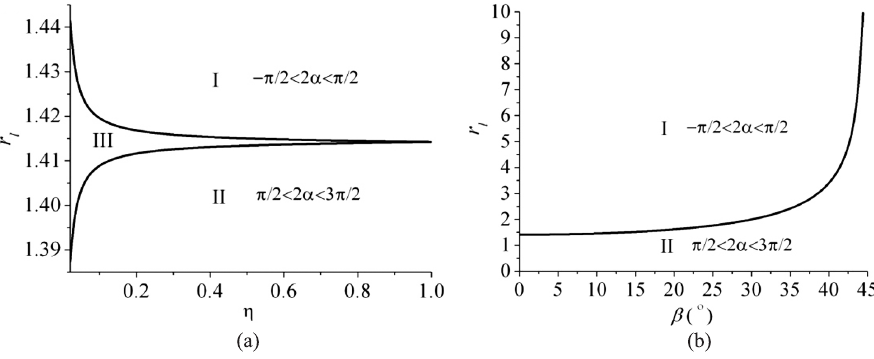
Fig. 3. Regions of frequency capture for the two identical motors: (a) β = 0 ; (b) β ∈ (0 , π/ 4]